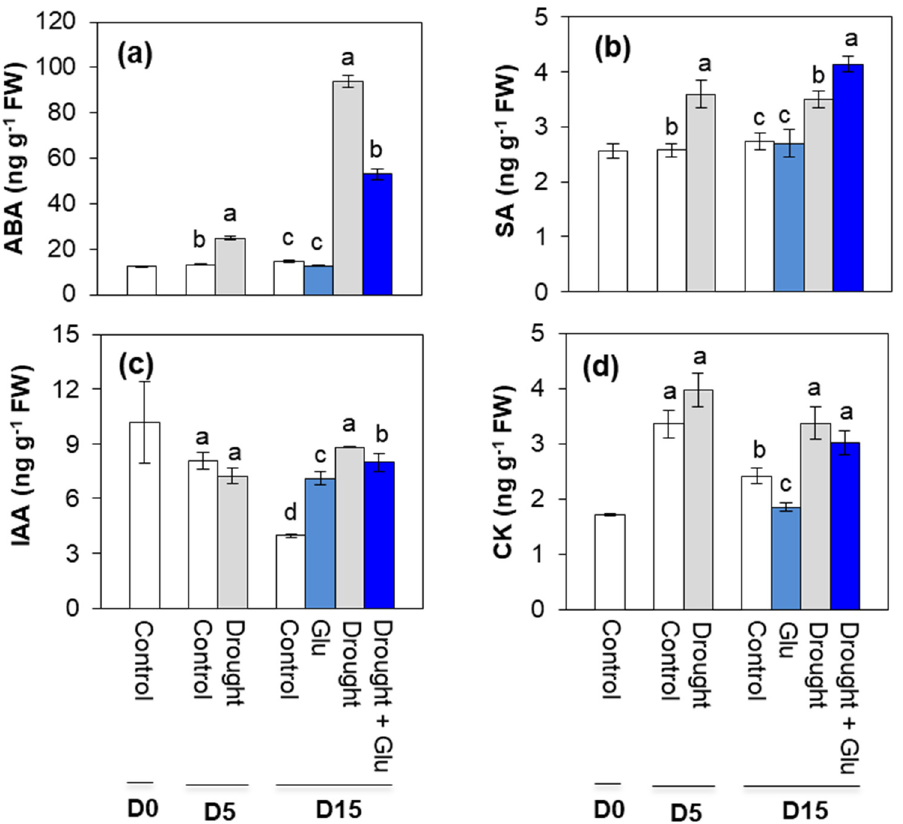
Figure 2. Effect of glutamate (Glu) application on endogenous phytohormone level in leaves of Brassica napus under well-watered or drought-stressed conditions. ( a ) Abscisic acid (ABA), ( b ) salicylic acid (SA), ( c ) indole-3-acetic acid (IAA), and ( d ) cytokinin (CK). Values are represented as mean ± SE ( n = 3). Different letters on columns indicate significant difference at p < 0.05 according to Duncan’s multiple range test.